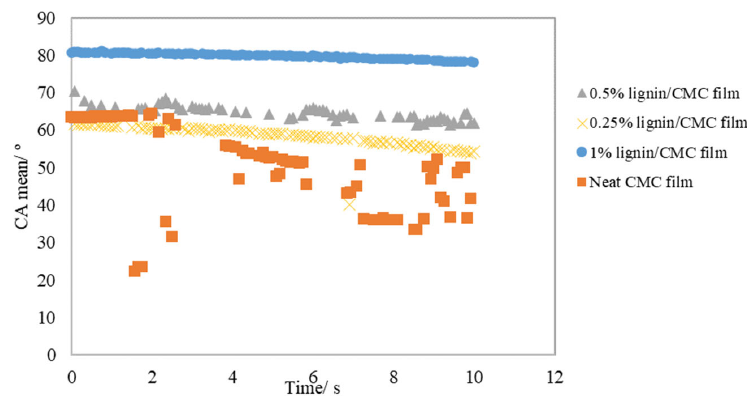
Figure 6. Mean contact angle of lignin/CMC films plotted against time.